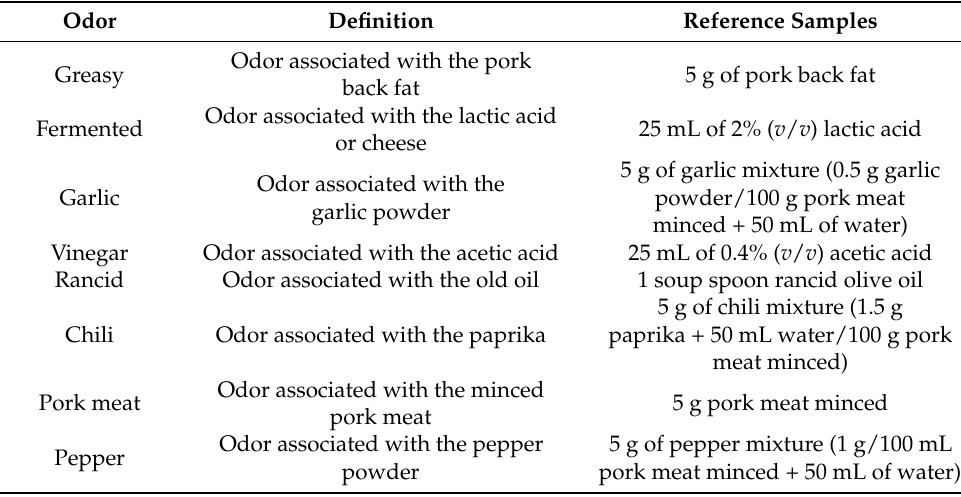
Table 2. Definition and references used to evaluate the odor